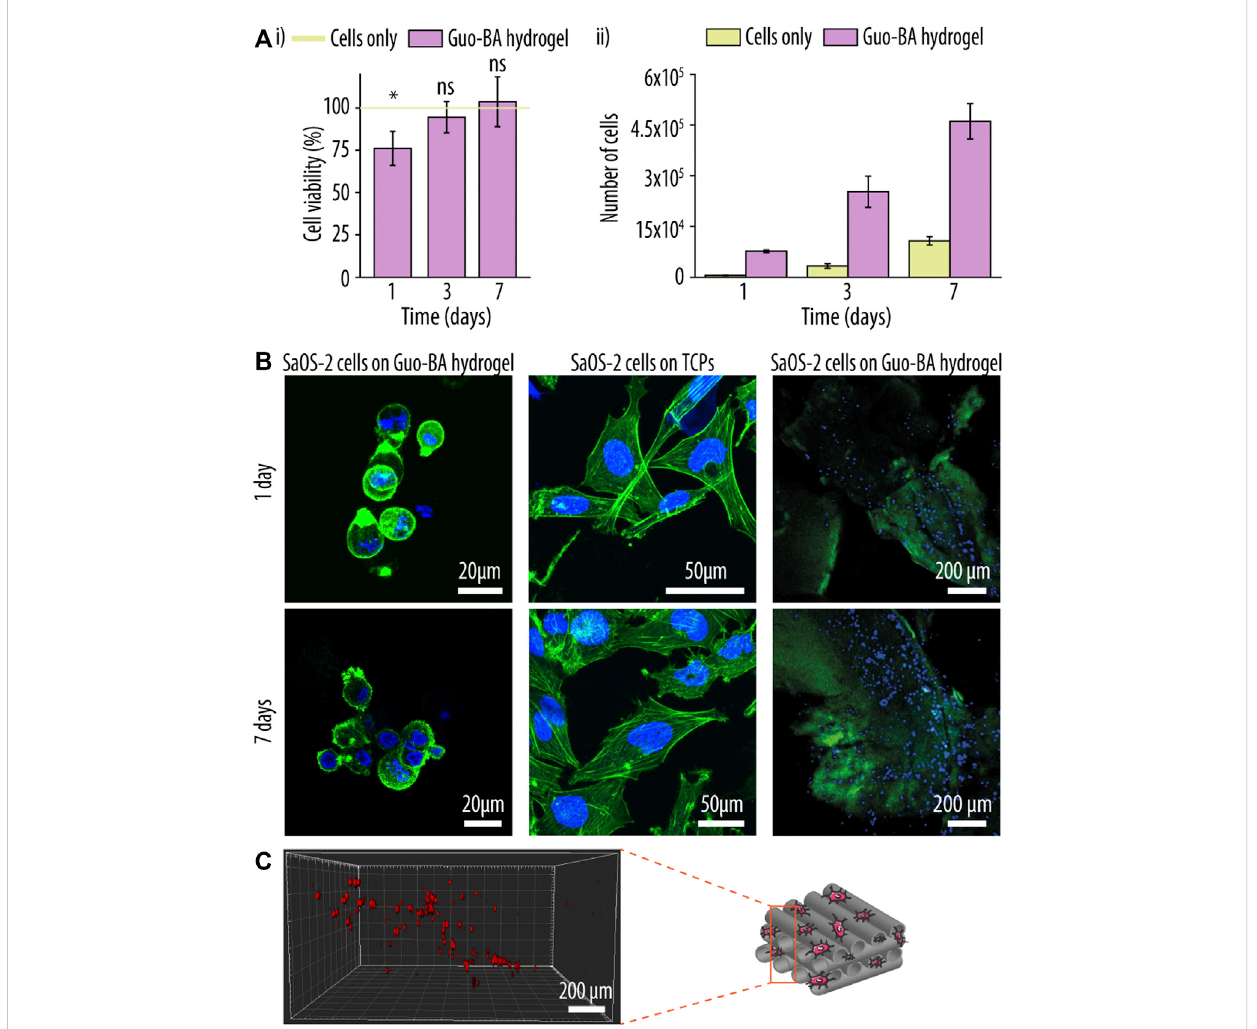
FIGURE 9 Post-printing cell functionalization of a guanosine (Guo)-based hydrogels with boric acid (BA) hydrogel. (A) Cell viability (i) and proliferation (ii) experiment of sarcoma osteogenic (SaOS-2) cells seeded onto the Guo-BA hydrogels up to 7 days. The green line represents 100% viability of the cells seeded on tissue culture polystyrene (TCPs) (control). Difference testing was done versus control. (B) Merged confocal laser scanning images of SaOS-2 cellsmorphologyseededontopofGuo-BAhydrogels,SaOS-2cellsmorphologyseededonTCPandSaOS-2celldistributiononGuo-BAhydrogels after1and7 daysofincubation.Actin fi lamentswerestainedwithphalloidin-Atto488(green fl uorescencesignal)andnucleiwithDAPI(blue fl uorescence signal). (C) three dimensional (3D) representation of SaOS-2 cells migration through the Guo-BA hydrogel after 7 days. Cells were stained with CellTracker ™ Deep Red